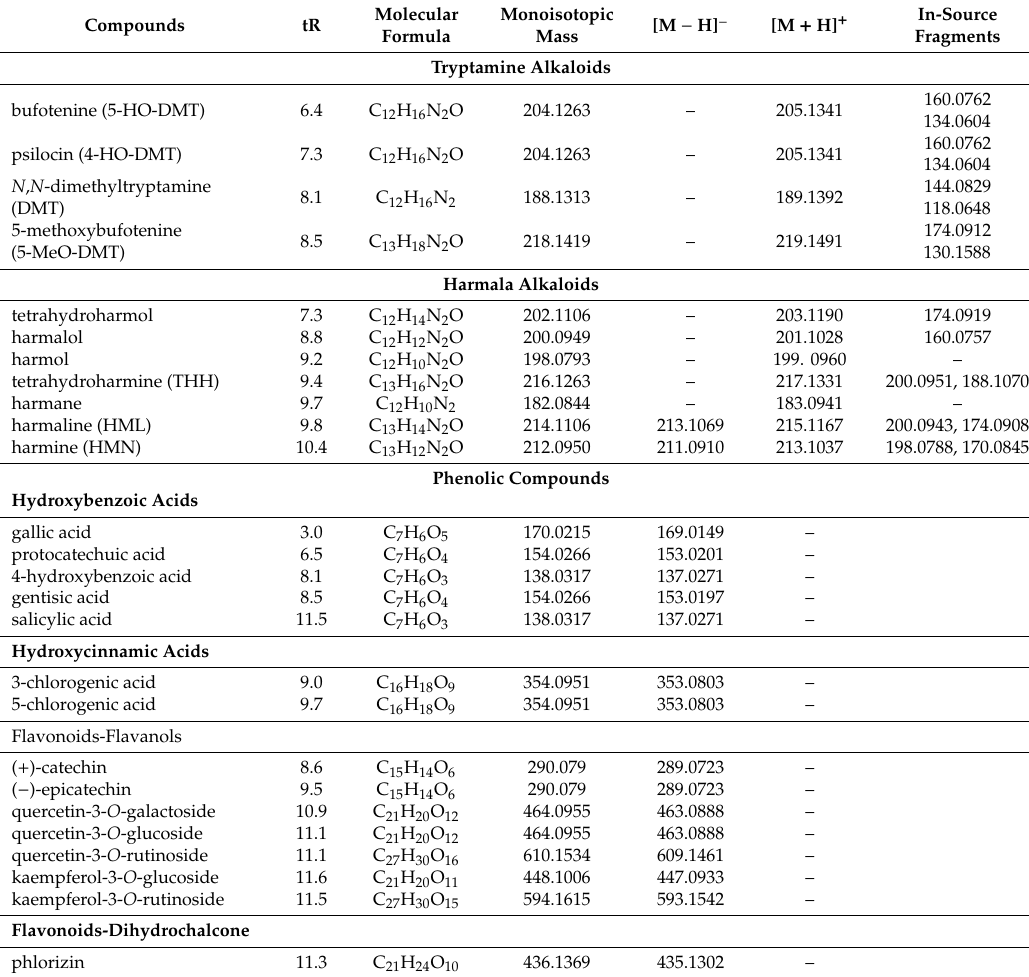
Table 1. Groups of the main tryptamine and harmala alkaloids and phenolic compounds identified in the methanol extracts by UHPLC-Q /